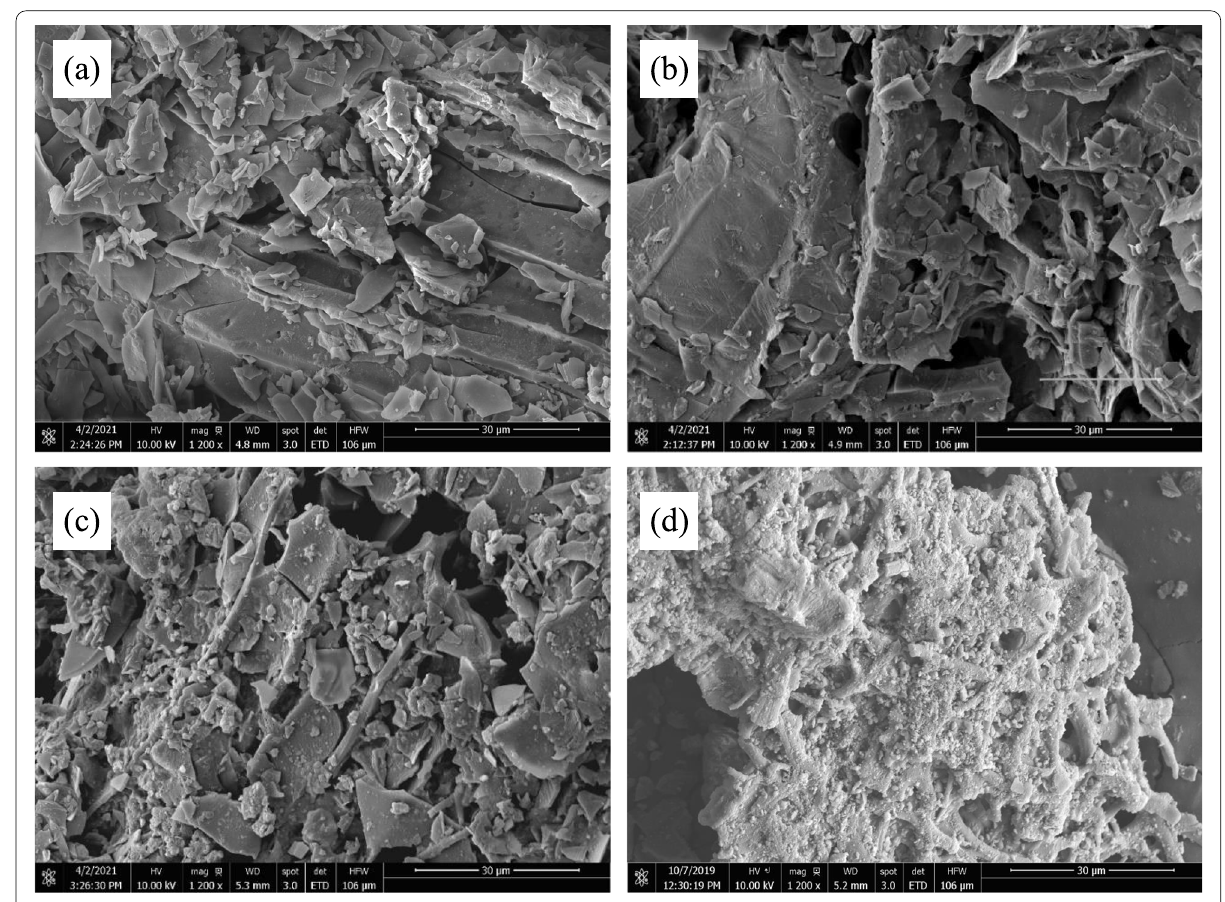
Fig. 3 SEM image on biochar surface of ( a ) CH, ( b ) CHC, ( c ) CHEG, and ( d ) eggshell